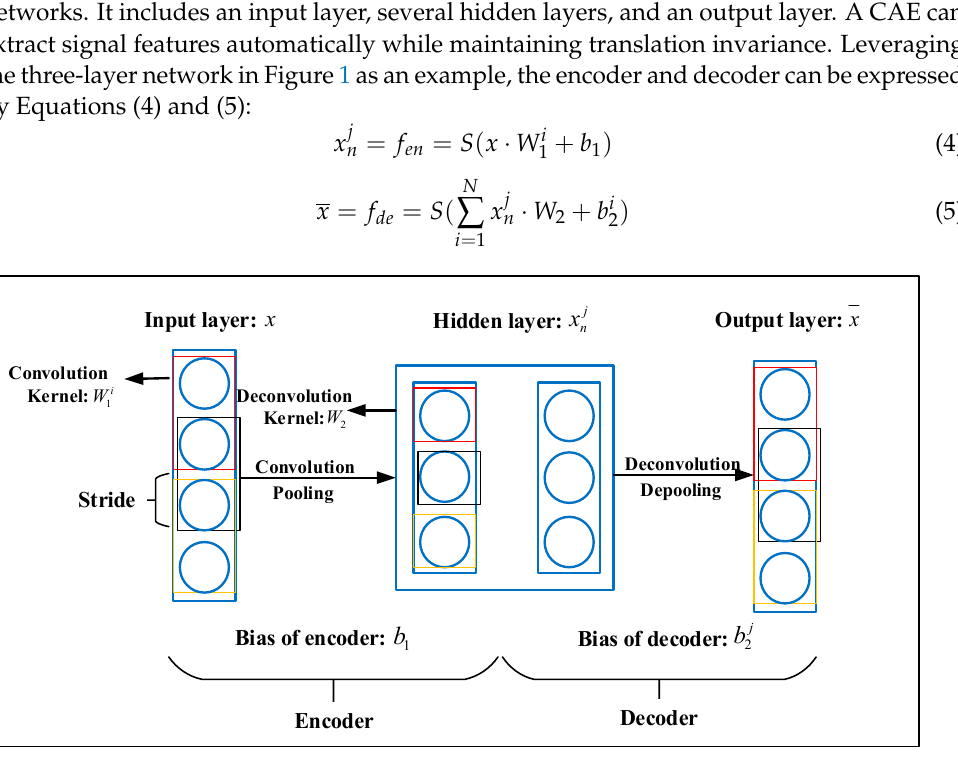
Figure 1. The network structure of convolutional auto ‐ encoder.